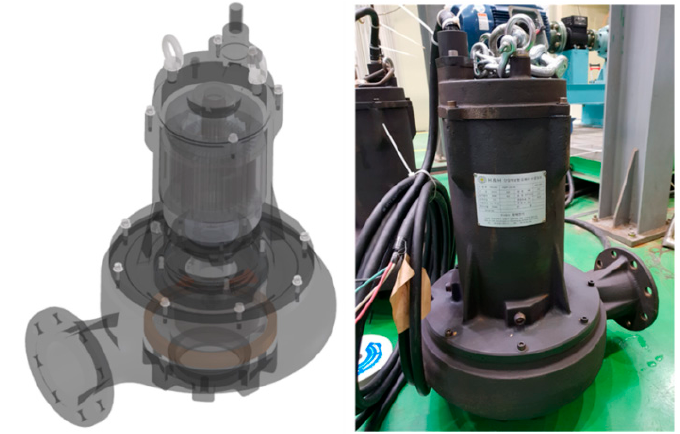
Figure 19. Prototype model for experimental test.